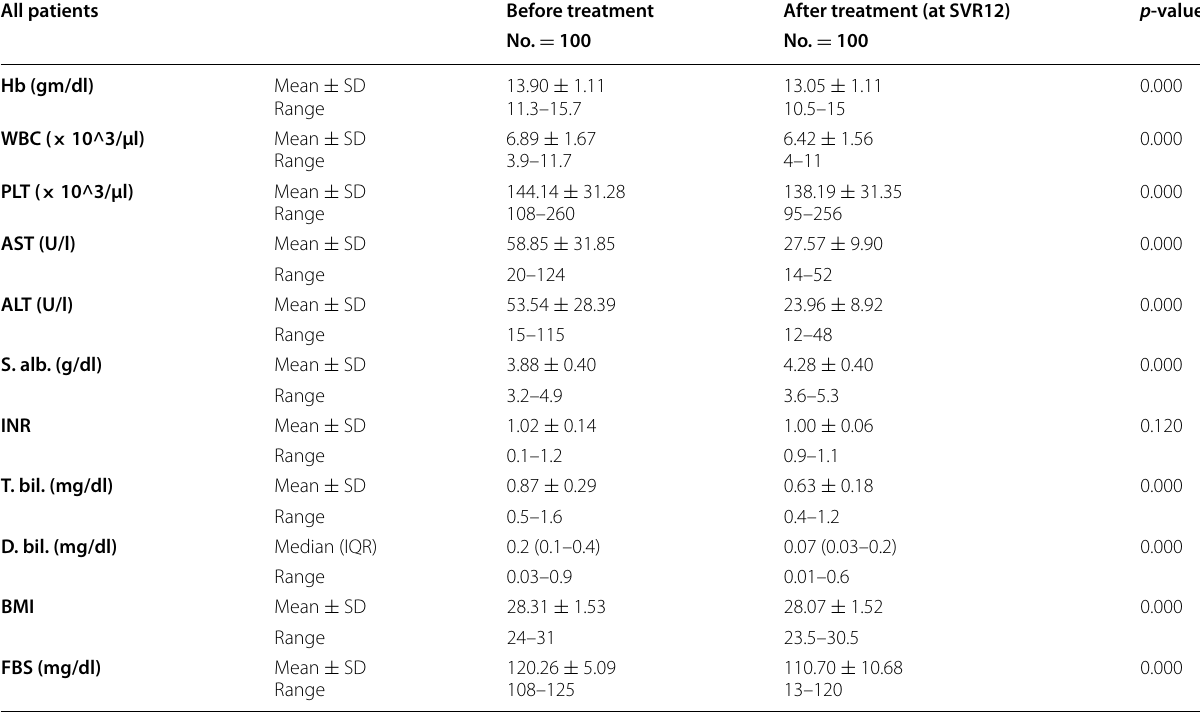
Table 1 Comparison between all studied patients’ data before and after treatment All patients Before treatment After treatment (at SVR12) p -value No. =